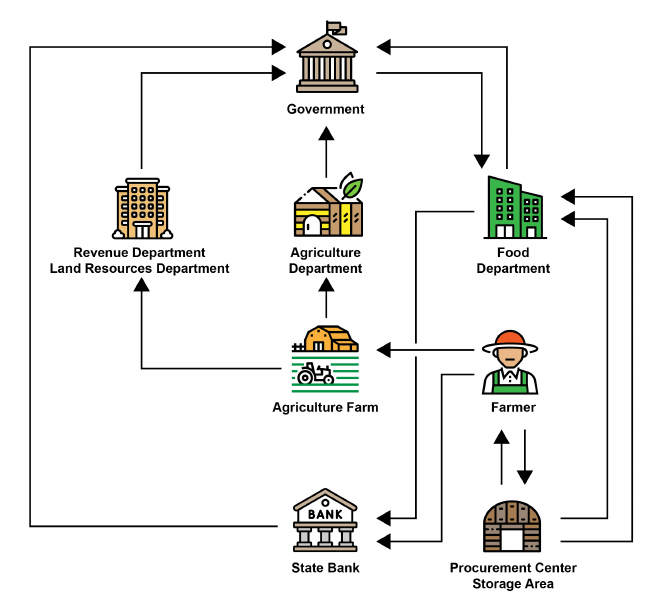
Figure 2. A traditional system of reserve grain management in the subcontinent region.